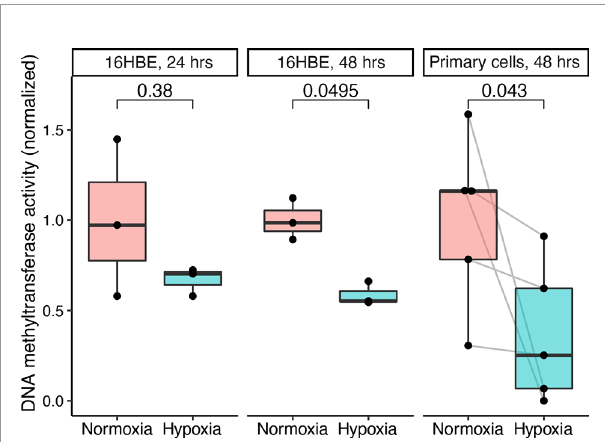
FIGURE 5 | Hypoxia attenuates DNA methyltransferase (DNMT) activity in human bronchial epithelial cells. The human bronchial epithelial cell line 16HBE140- was cultured and exposed to 1 or 21% oxygen for 24 or 48 h. Similarly, primary epithelial cells cultured from small airway brushes were exposed to 1 or 21% oxygen for 48 h. DNMT activity was measured and normalized to the normoxia group mean values. Hypoxia and normoxia values were compared in 16HBE140- cells using the Wilcoxon rank sum test and in primary cells using the Wilcoxon signed rank test (paired by subject identi fi